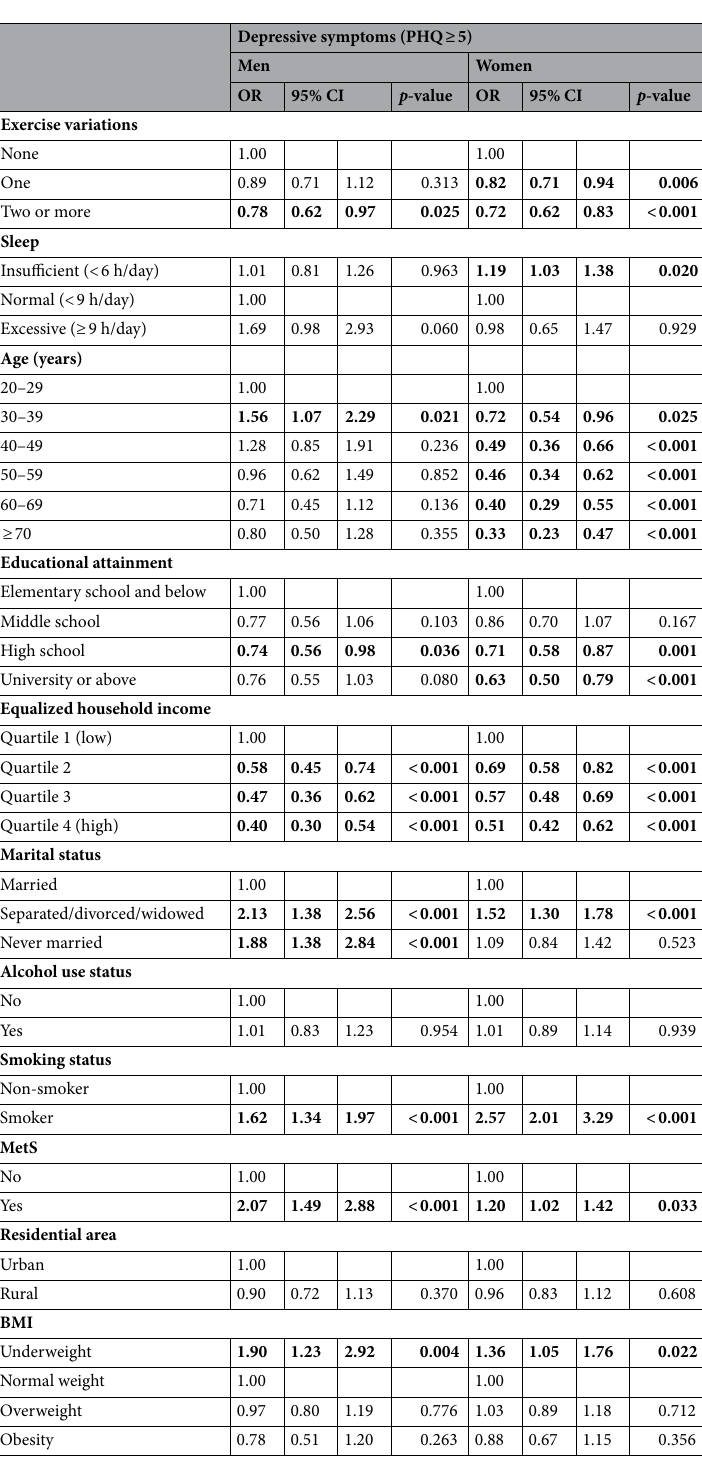
Table 2. Results of the multivariable logistic regression analysis for the association between exercise and depressive symptoms in precarious employees. PHQ-9 patient health questionnaire-9, MetS metabolic syndrome, BMI body mass index, OR odds ratio, CI confidence interval. Bold values denote a p-value of